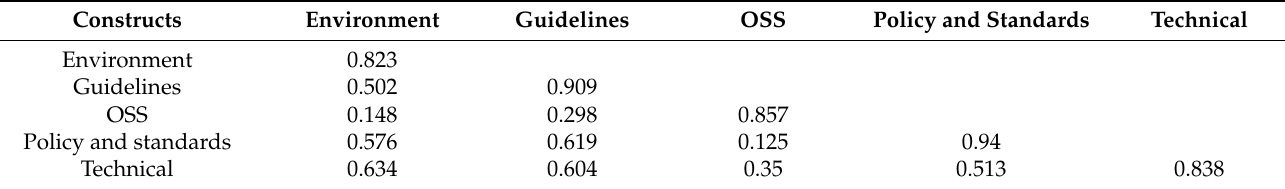
Table 4. Discriminant validity analysis